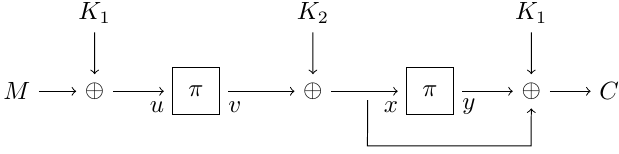
Figure 2: SoKAC1 - One permutation instance π (= π 1 = π 2 ), two key instances K 1 and K 2